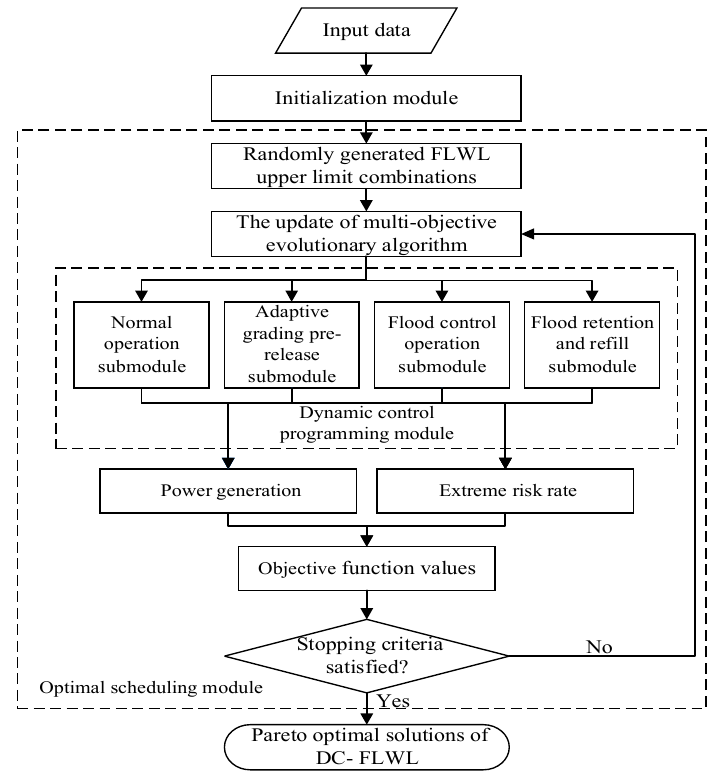
Figure 1. Framework of the multi-objective optimal scheduling model of dynamic control of flood limited water level (DC-FLWL) for cascade reservoirs.